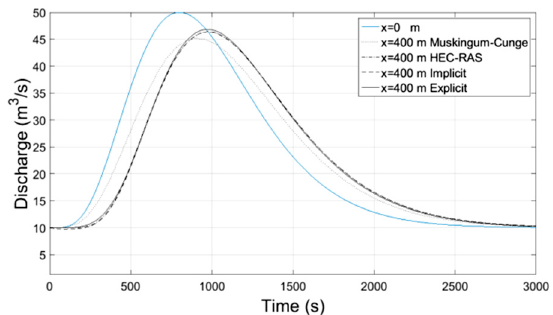
Figure 18. Flow Depth-Time at x = 400 m.